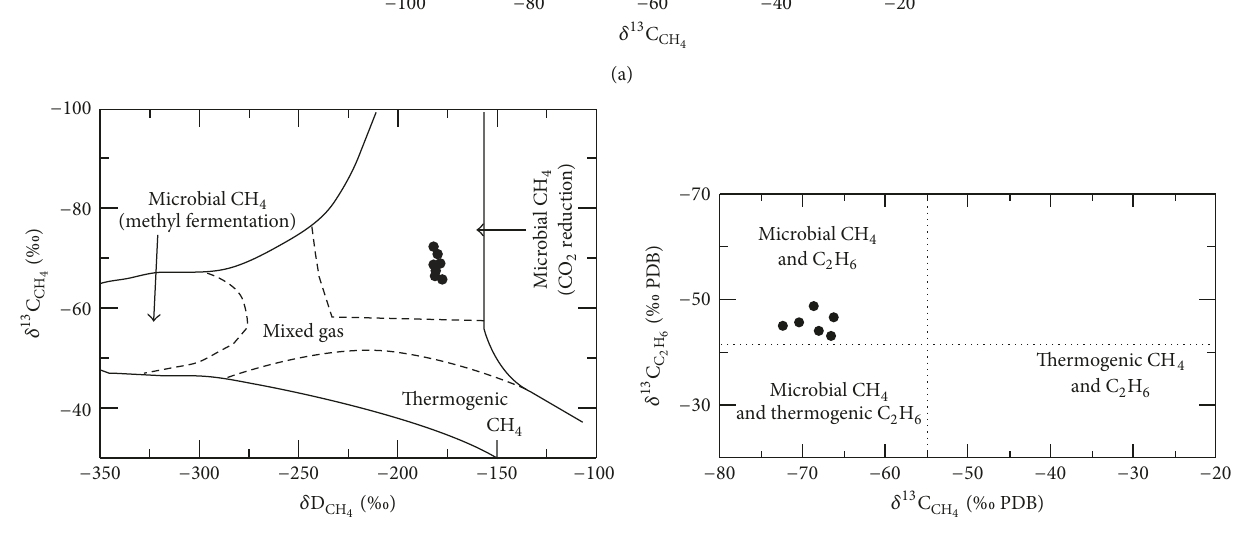
versus methane to (ethane and propane) molecular 4 versus 𝛿 13 C CH (modified after Schoell, 1983, and Whiticar, 1999); and (c) 4 4